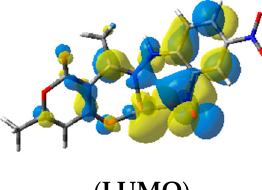
( HOMO) ( LUMO ) Figure 2. Contour plots of HOMOs and LUMOs for the copper complex structure optimized at the B3LYP/6-31G* level of theory.